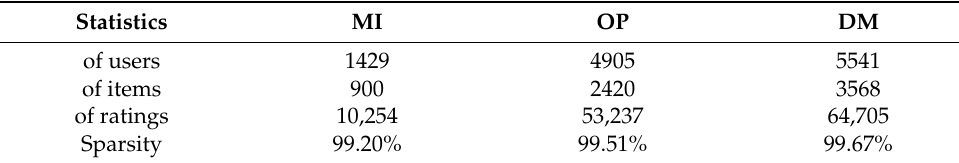
Table 2. Statistics of the